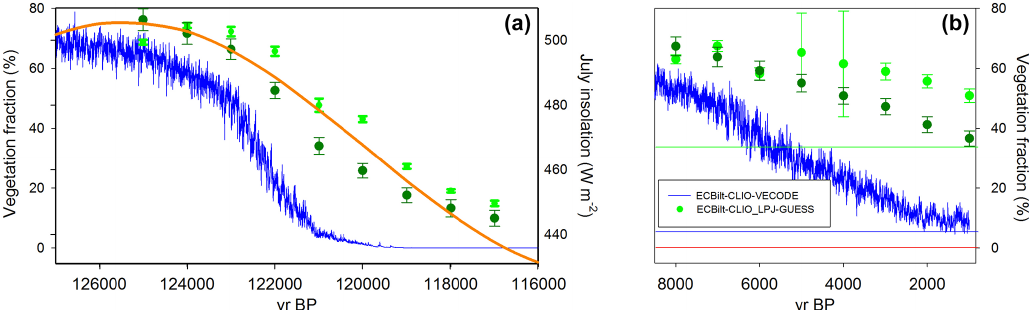
Figure 2. Total vegetation cover during the LIG (a) and the Holocene (b) . The blue lines are simulated results from transient experiments with dynamical vegetation (LIG_VEC and HOL_VEC). The light green dots with error bars are simulated results from experiments with asynchronously coupled “dynamical” vegetation (LIG_LPJ and HOL_LPJ). The dark green dots with error bars are vegetation results from LPJ-GUESS forced offline with climatic forcing from LIG_VEC and HOL_VEC. The blue, red, and light green horizontal lines indicate pre-industrial vegetation cover from PI_VEC, PI_FIX, and PI_LPJ,